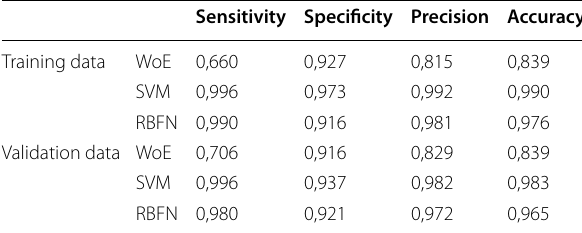
Table 3 Statistical indices of different prediction